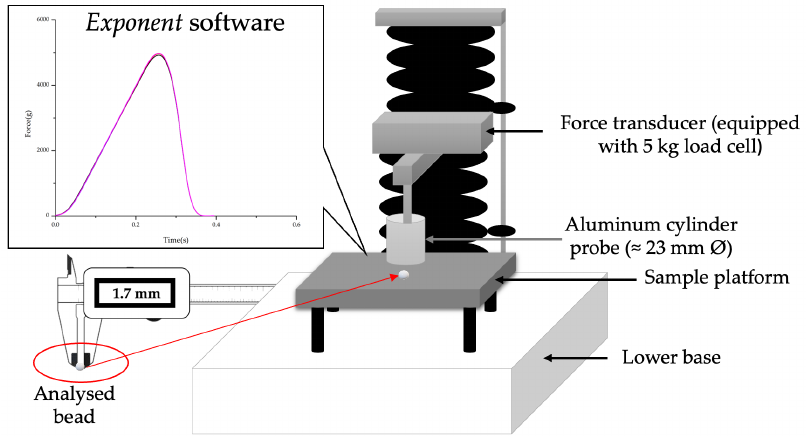
Figure A6. Schematic representation of the Texture Analyser (TA-XT2 Plus) setup for beads mechanical studies.